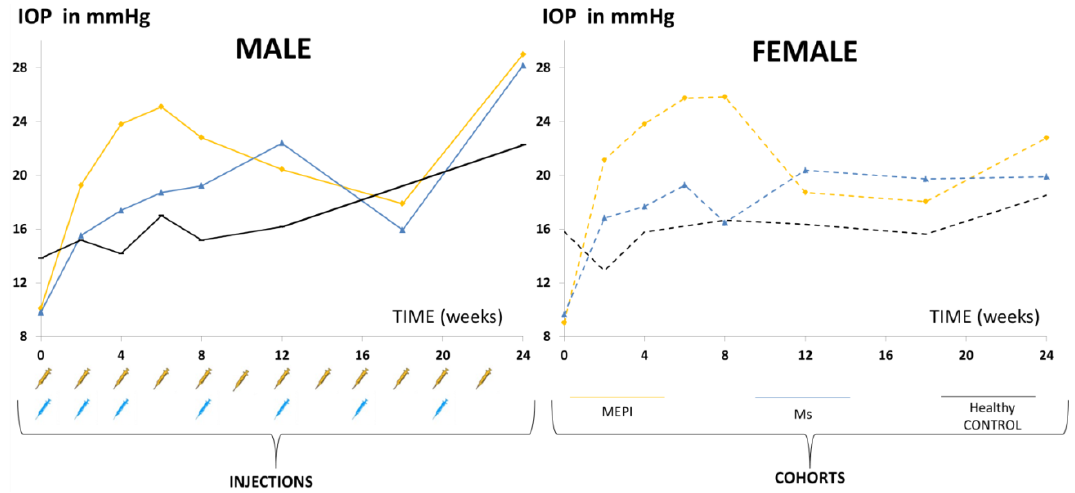
Figure 2. Intraocular pressure curves (right eyes) in two models of chronic glaucoma and healthy controls. Abbreviations: MEPI: glaucoma model induced by sclerosing the episcleral veins; Ms: glaucoma model induced by injection of PLGA microspheres; IOP: intraocular pressure (data extracted from [50,62]).